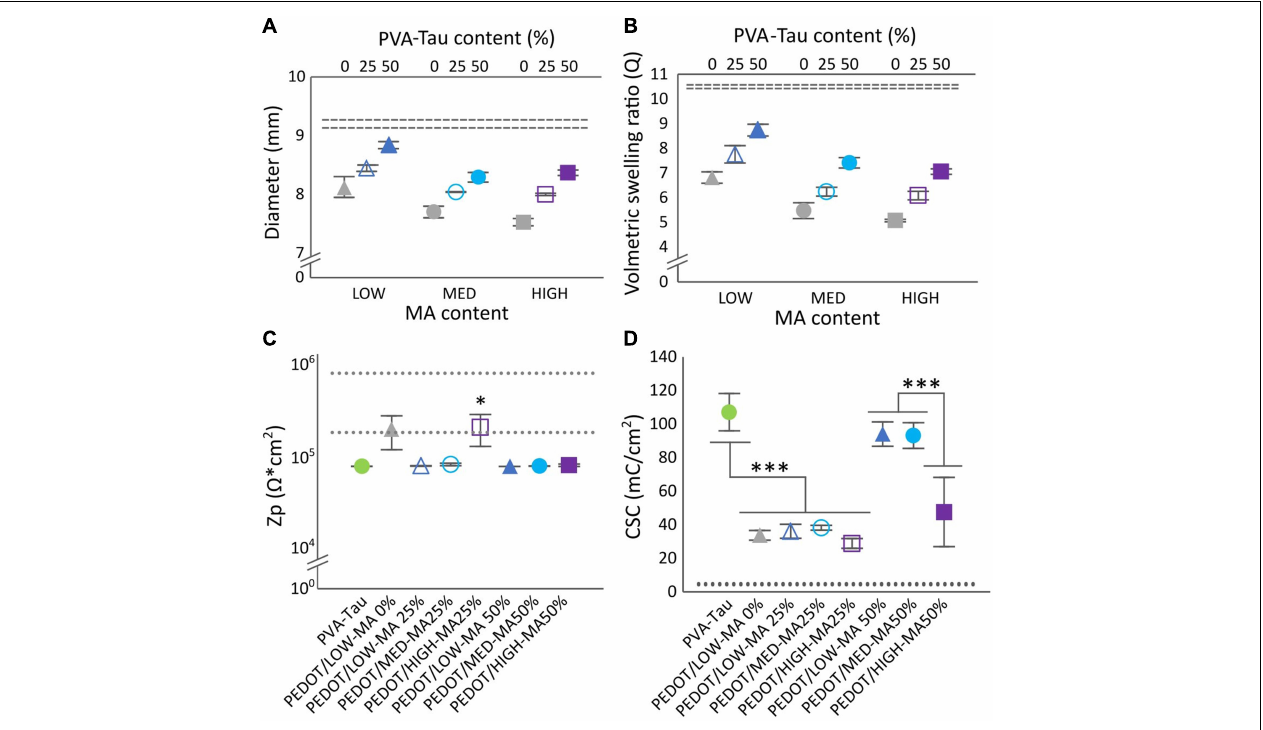
FIGURE 3 | Effect of number MA groups per PVA chain and PVA-Tau content on hydrogels diameter (A) , and volumetric selling ratio (B) . Dashed lines represent the HS variant, 100% PVA-Tau 95% confidence intervals ( n = 3, N = 9). (C) Polarisation impedance (Zp) and (D) charge storage capacity (CSC) of CH coated MEs. The dotted lines show the 95% confidence intervals for the Zp and CSC levels of uncoated Pt MEs. *0.05 > p > 0.01, *** p < 0.001. Error bars are ± 1